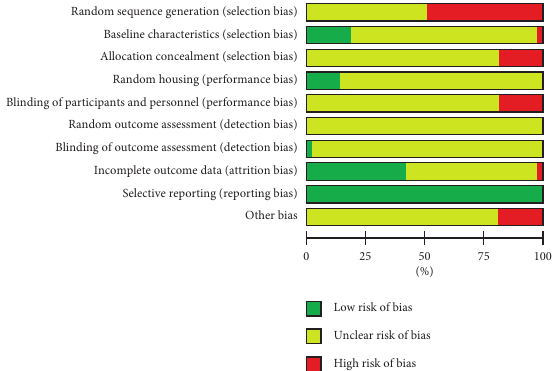
Figure 5: Risk of bias assessment within the 43 included